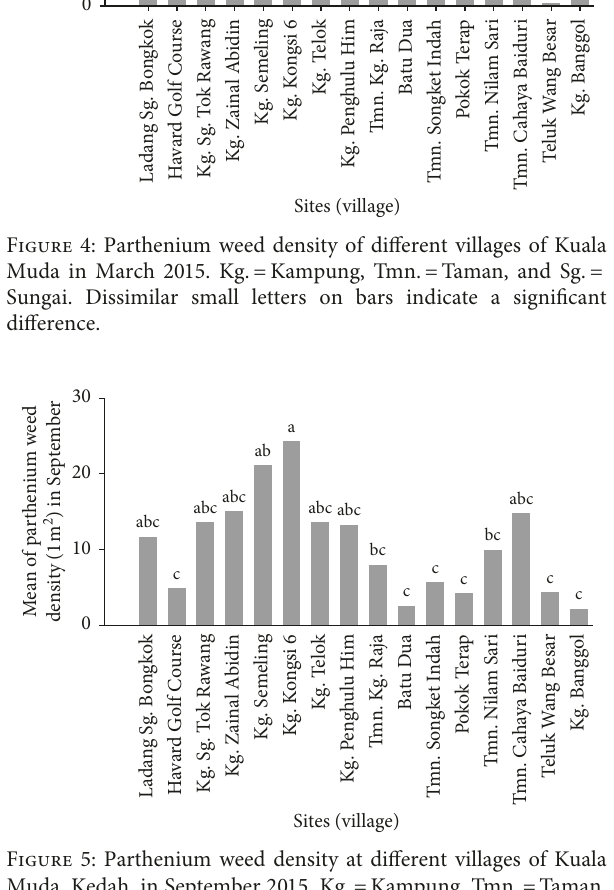
Figure 8: Percent coverage by parthenium weed in different vil- lages of Kuala Muda in September 2015. Kg. � Kampung, Tmn. � Taman, and Sg. � Sungai. Dissimilar small letters on bars indicate a significant difference.